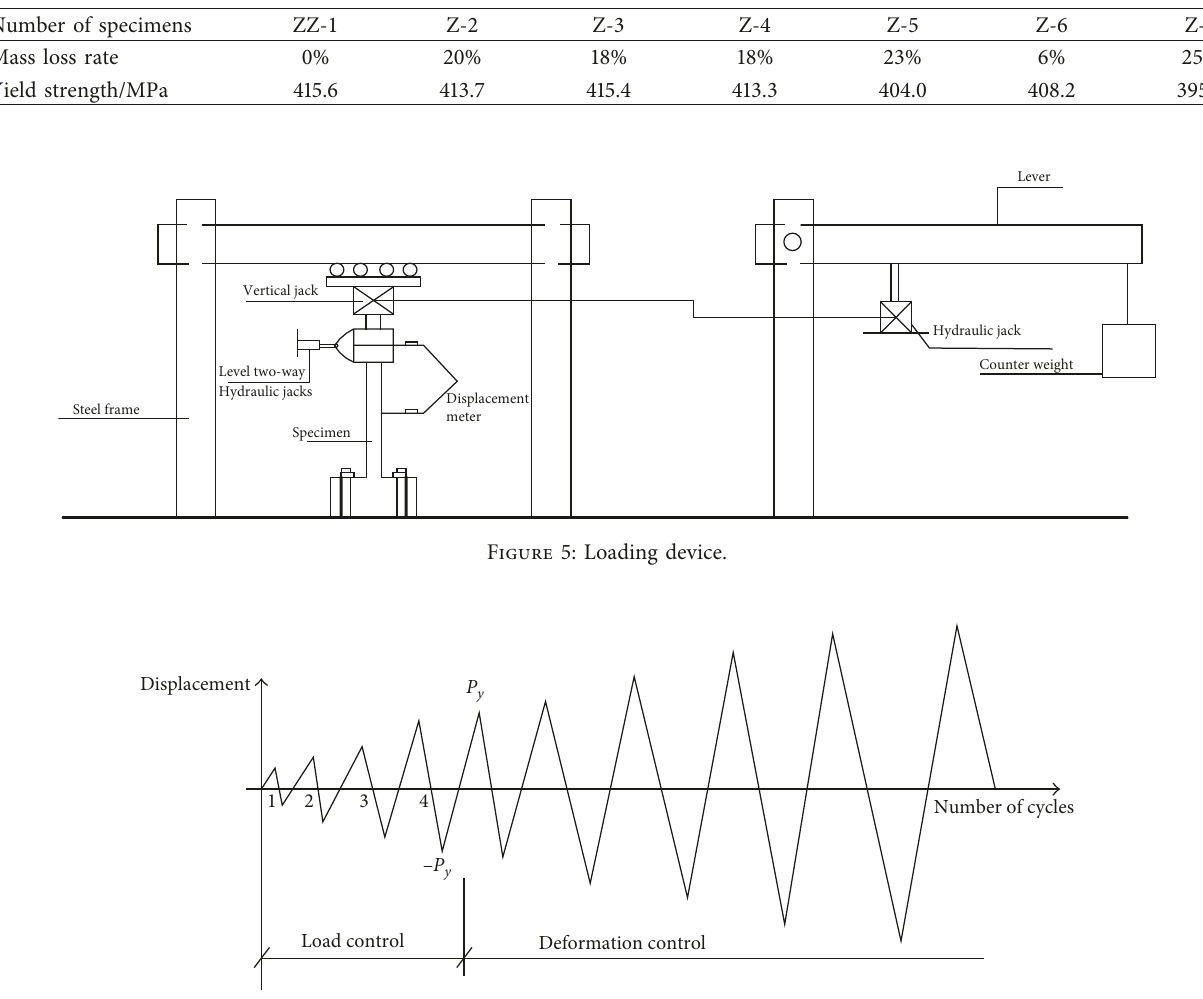
Figure 6: Lateral displacement